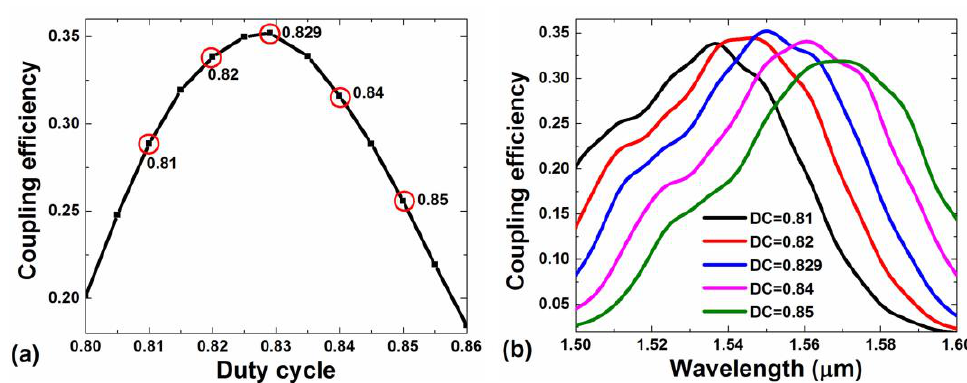
Figure 7. ( a ) Coupling efficiency as a function of duty cycle. ( b ) Coupling efficiency as a function of wavelength for different duty cycle.